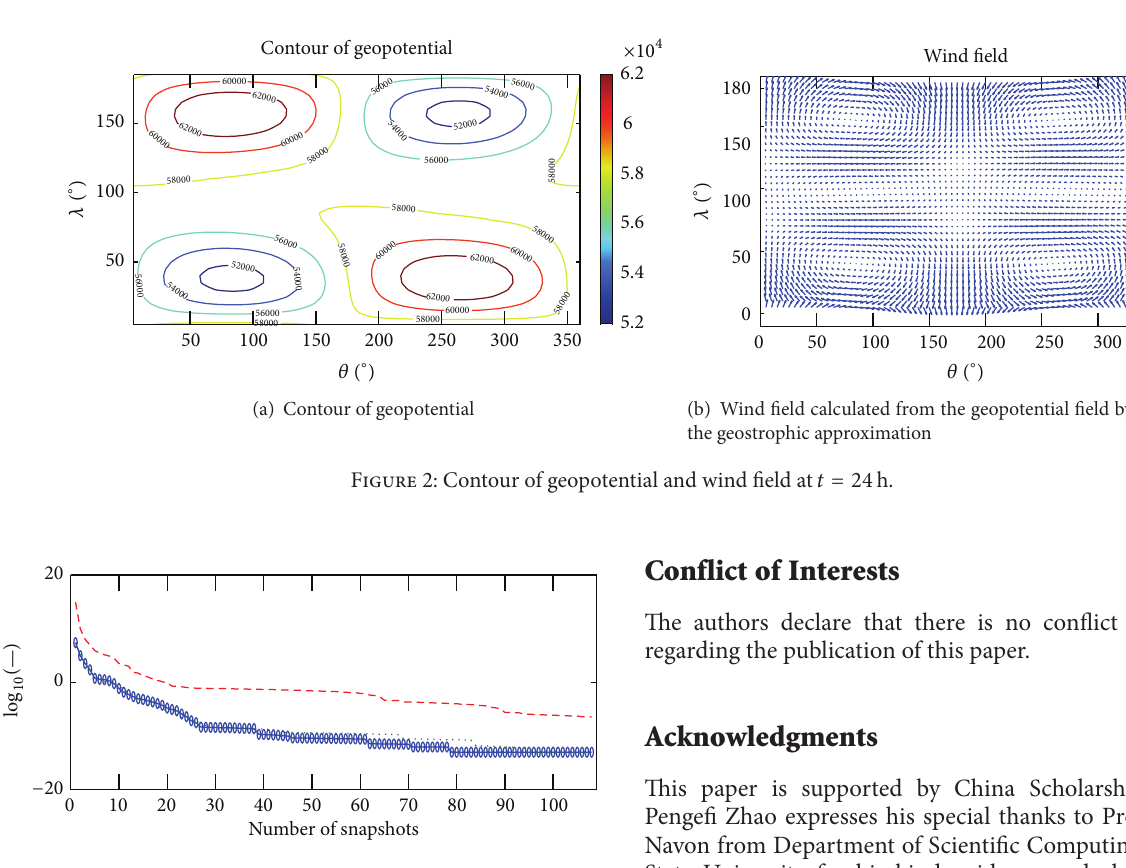
(b) Wind field calculated from the geopotential field by using the geostrophic approximation Figure 1: Contour of geopotential and wind field at 𝑡 = 0 .